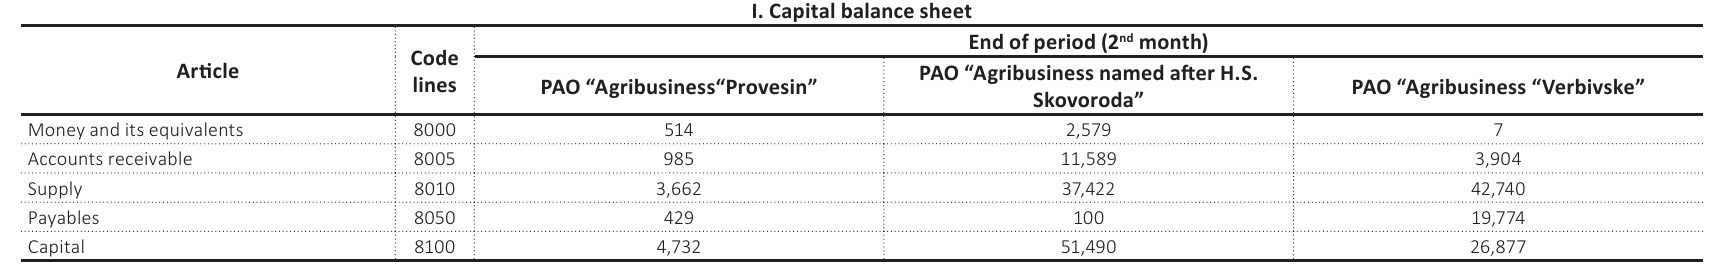
Table 2. “Actuarial Force Report on Capital Impulse” (3D AFRCI) of Form 5a